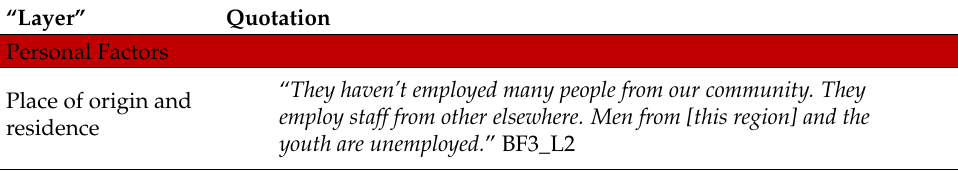
Table A1. Exemplary quotes for the different layers of inequities (including a code indicating